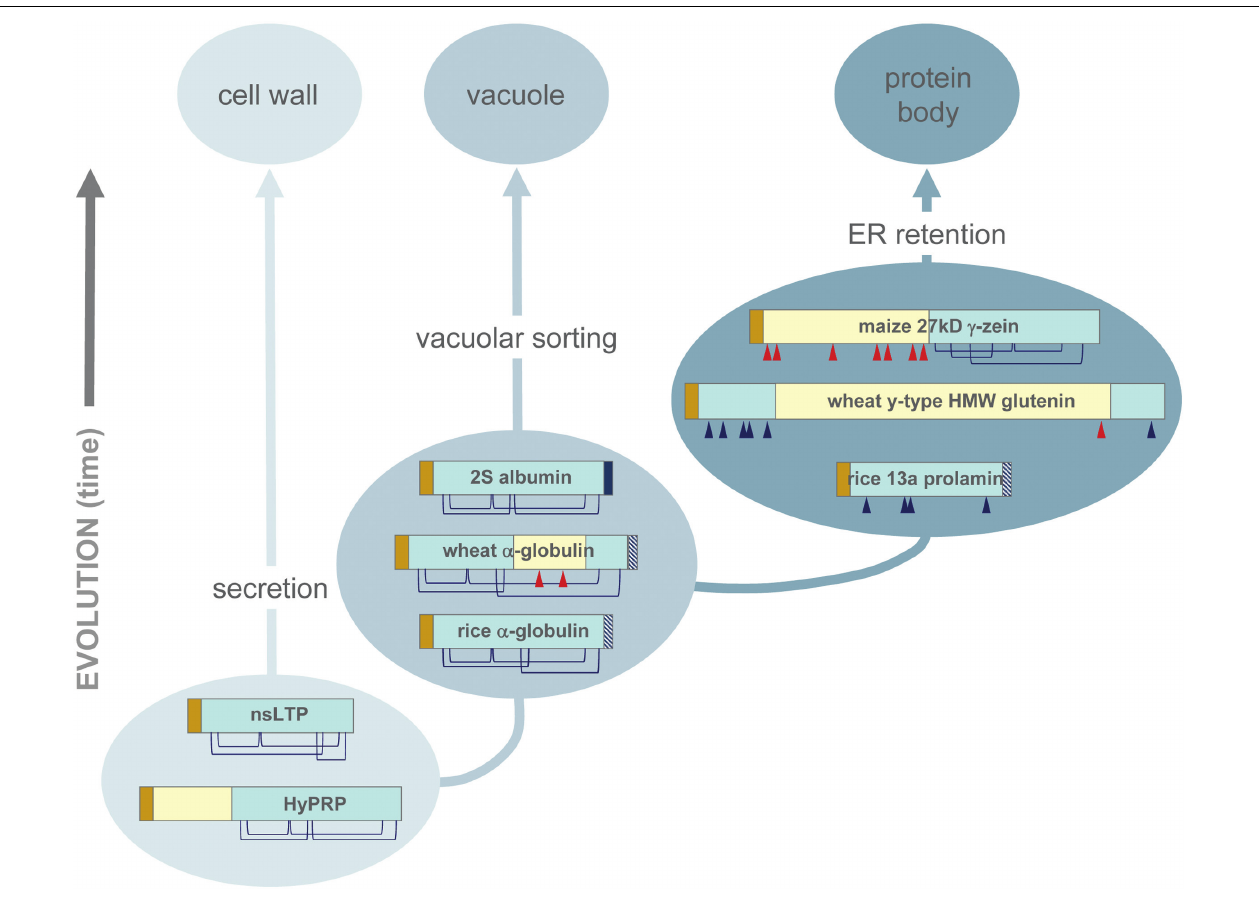
FIGURE 1 | A model of the evolutionary events at the origin of protein bodies. The model describes the origin of prolamins that are self-sufficient for PB formation and probably have a dominant effect on those that evolved later. Proteins with 8CM motifs are secreted or sorted to the vacuole, depending on the presence or not of vacuolar sorting signals. Insertions that do not alter the disulphide bonds of the 8CM motif do not affect protein destiny. Extensive polymerization that leads to PB formation can result from insertions that inhibit the correct formation of the four intra-chain bonds, deletions that involve the loss of critical Cys residues, or additions of domains containing new Cys residues. The repetitive domains may also mediate interactions with the ER membrane. Vacuolar sorting signals may be present or absent in PB proteins, but PB formation has anyway a dominant effect on intracellular traffic. Phylogenetic analysis and the results of protein engineering and expression of individual genes indicate that the PB forming prolamins evolved from superfamily members that are sorted to the vacuole, not from secreted members. The schematic protein structures are based on the following GenBank accessions: EU968356.1 (maize nsLTP), EU964401.1 (maize HyPRP), CAA40015.1 (2S albumin), ABG68034.1 (wheat α -globulin), BAA09308.1 (rice α -globulin), 27 kD zein, ABG68035.1 (wheat y-type HMW glutenin), and BAA36697.1 (rice 13a prolamin). Brown: signal peptide; light blue: conserved 8CM motif, or portions of it; yellow: Pro-rich or Glu-rich domain; blue: vacuolar sorting sequence; striped blue: putative vacuolar sorting sequence; blue lines: intra-chain disulphide bonds of the 8CM motif; blue triangles: Cys residues originating from the 8CM motif; red triangle: Cys residues that do not originate from the 8CM motif.